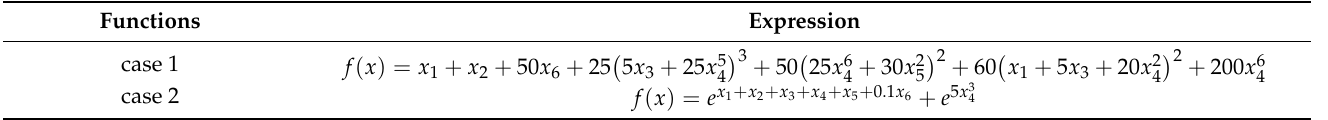
Table 3. Function